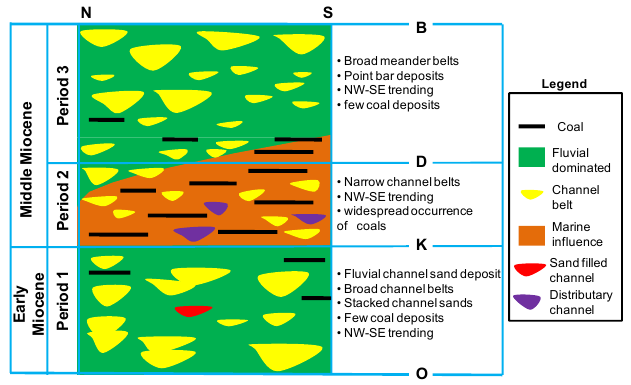
the channel belts between period 3.